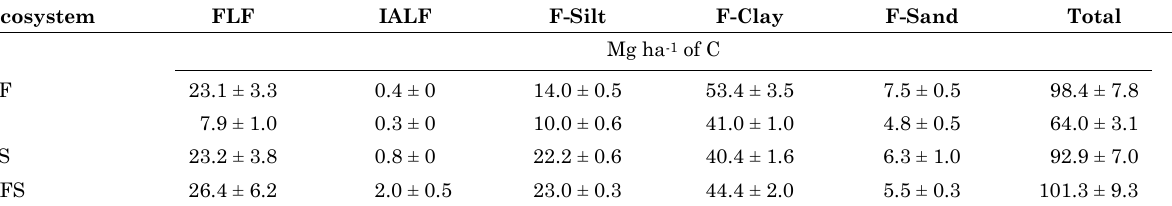
Table 3. Total carbon stocks in the soil fractions up to a 200 cm depth in primary forest (PF), pasture (P), secondary succession (SS), and agroforestry system (AFS) in Central Amazonia Ecosystem FLF IALF F-Silt F-Clay F-Sand Total Mg ha -1 of C 23.1 ± 3.3